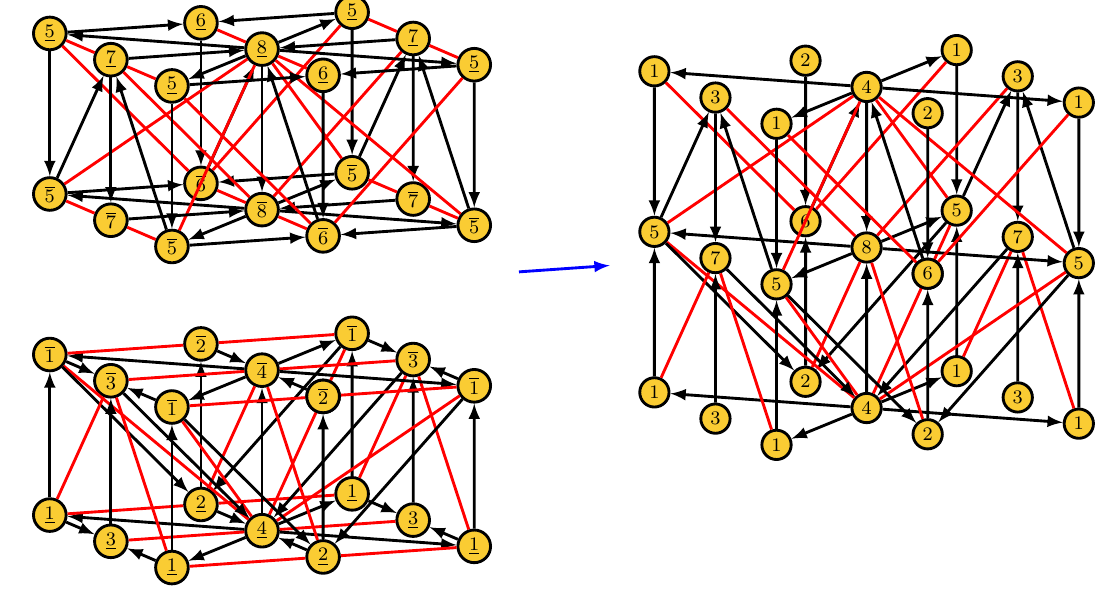
Figure 17. 3 d printing for phase D of Q 1 ; 1 ; 1 = Z 2